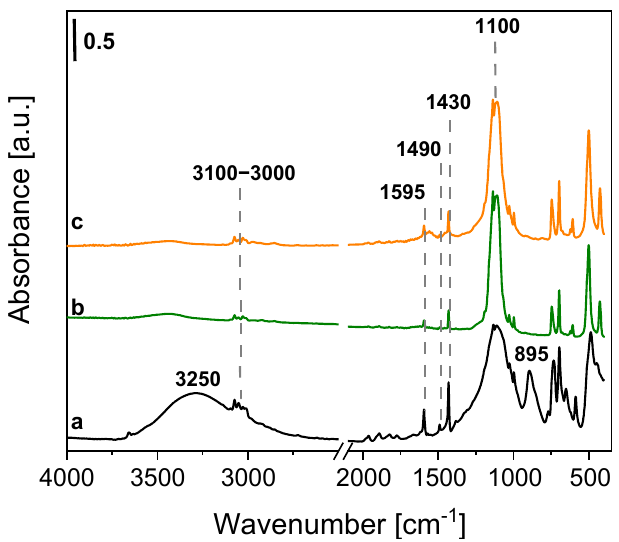
Figure 2. FT-IR spectra of PhPOSS POSS (a), Tb-PhPOSS (b) and TbEu-PhPOSS (c), collected in KBr matrix (10 wt%).